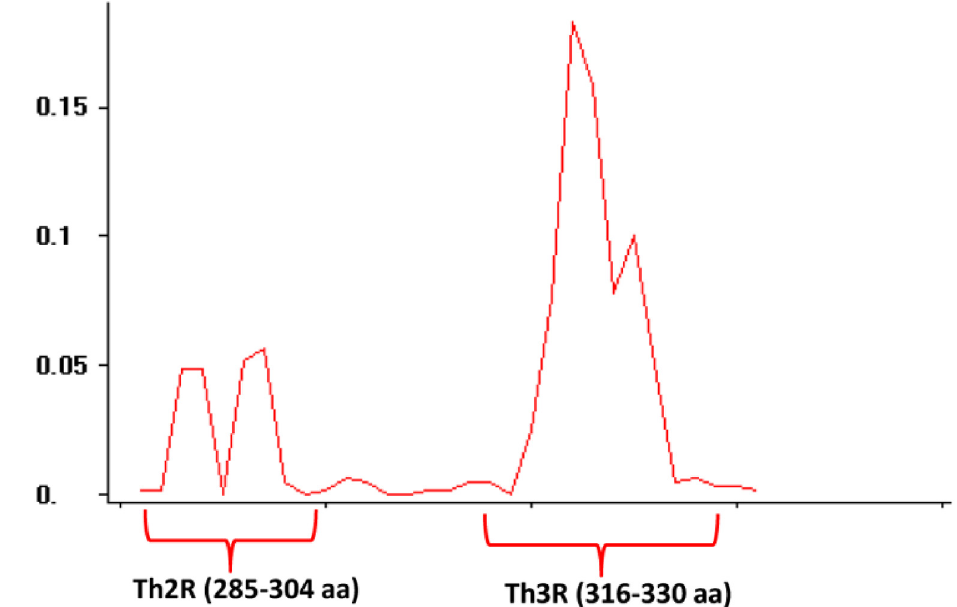
Fig 4. Sliding window (size = 10 bp, length = 5 bp) analysis of genetic diversity ( π ) across the Th2R/Th3R region. The x-axis represents CSP amino acid positions 278 to 336. The Th2R and Th3R regions are